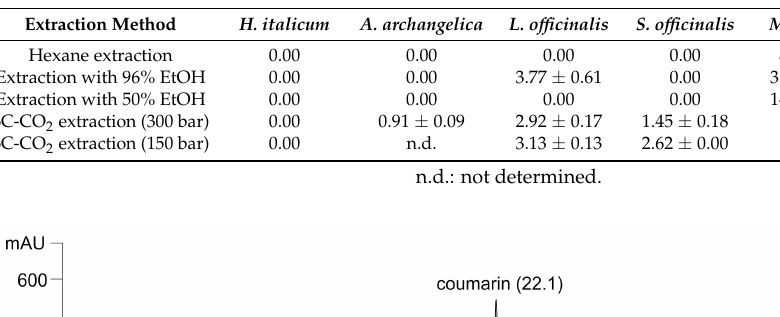
Table 2. Coumarin concentration (mg/100 g) in the plant extracts.